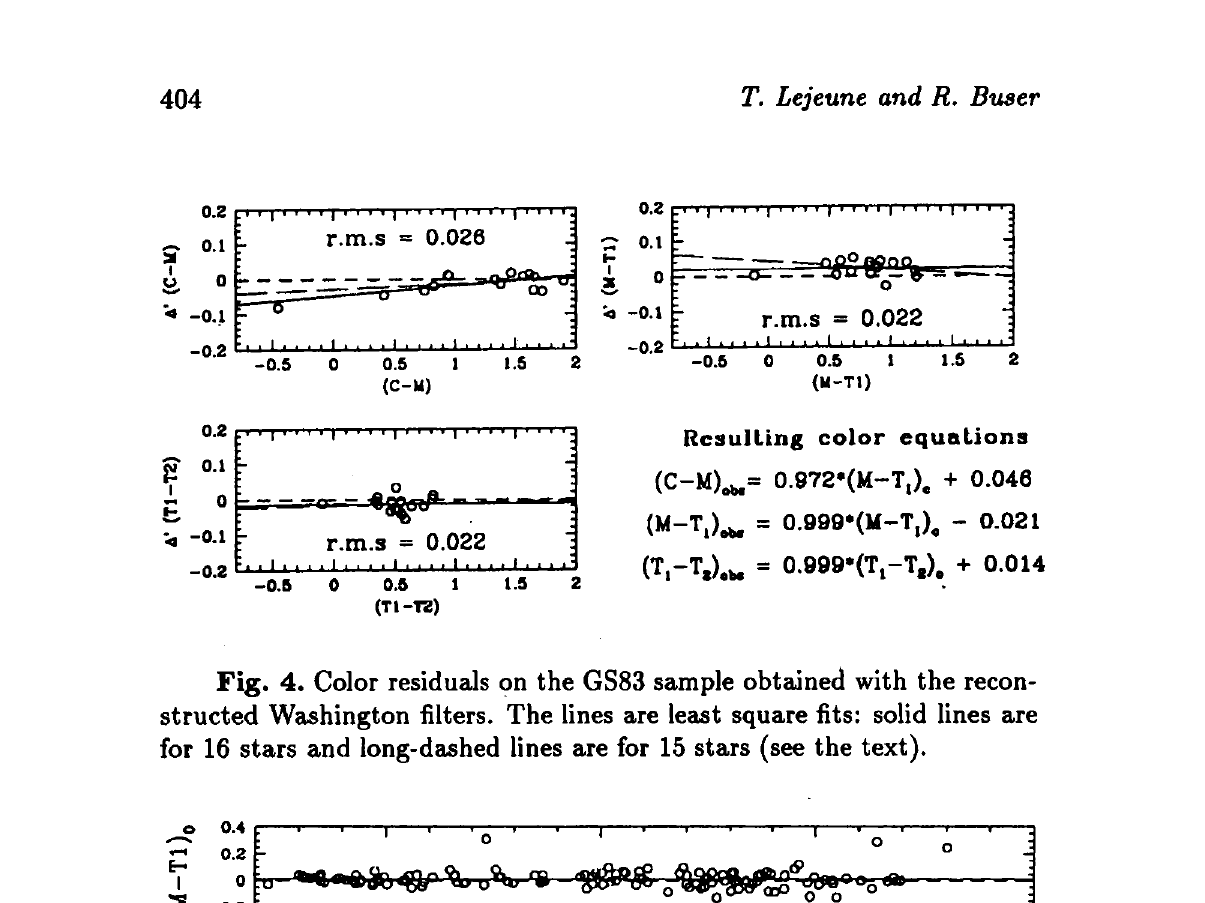
Fig. 4. Color residuals on the GS83 sample obtained with the recon- structed Washington filters. The lines are least square fits: solid lines are for 16 stars and long-dashed lines are for 15 stars (see the text).